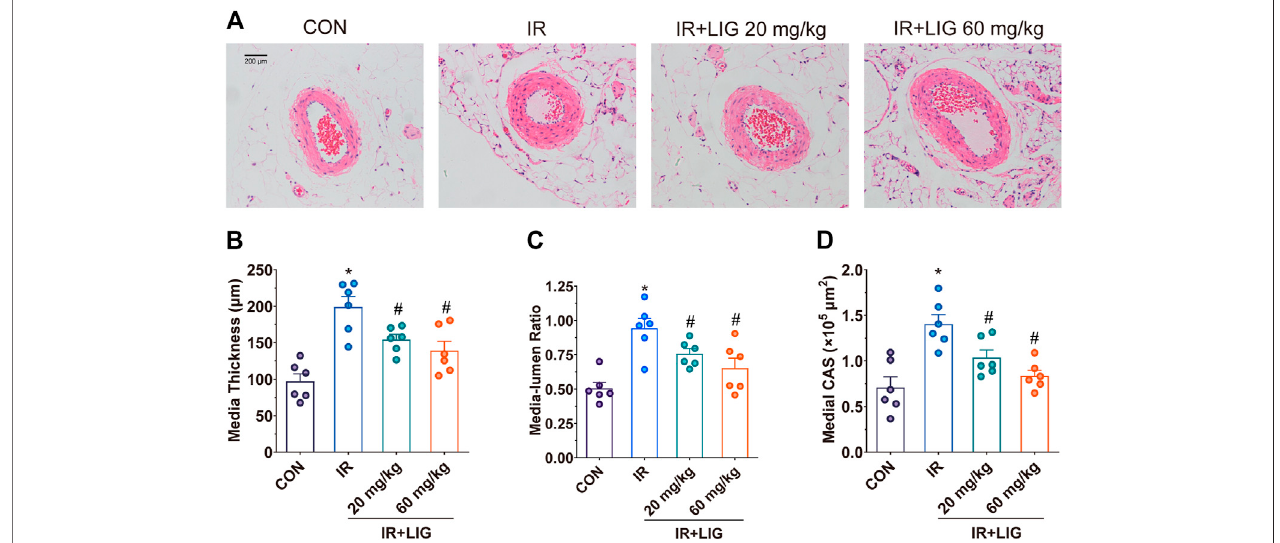
FIGURE2| Effects ofLIG onmesenteric artery remodeling inrats after IR. (A) Representativehematoxylin-eosinstaininghistopathologicalimages after 3 weeksof IR.Vascularremodelingwasevaluatedby (B) mediathickness, (C) media-lumenratio,and (D) medialCSA.CSA,medialcross-sectionalarea.Dataarethemean ± SEM; n (cid:1) 6. * p < 0.05, signi fi cantly different from the CON group; # p < 0.05, signi fi cantly different from the IR